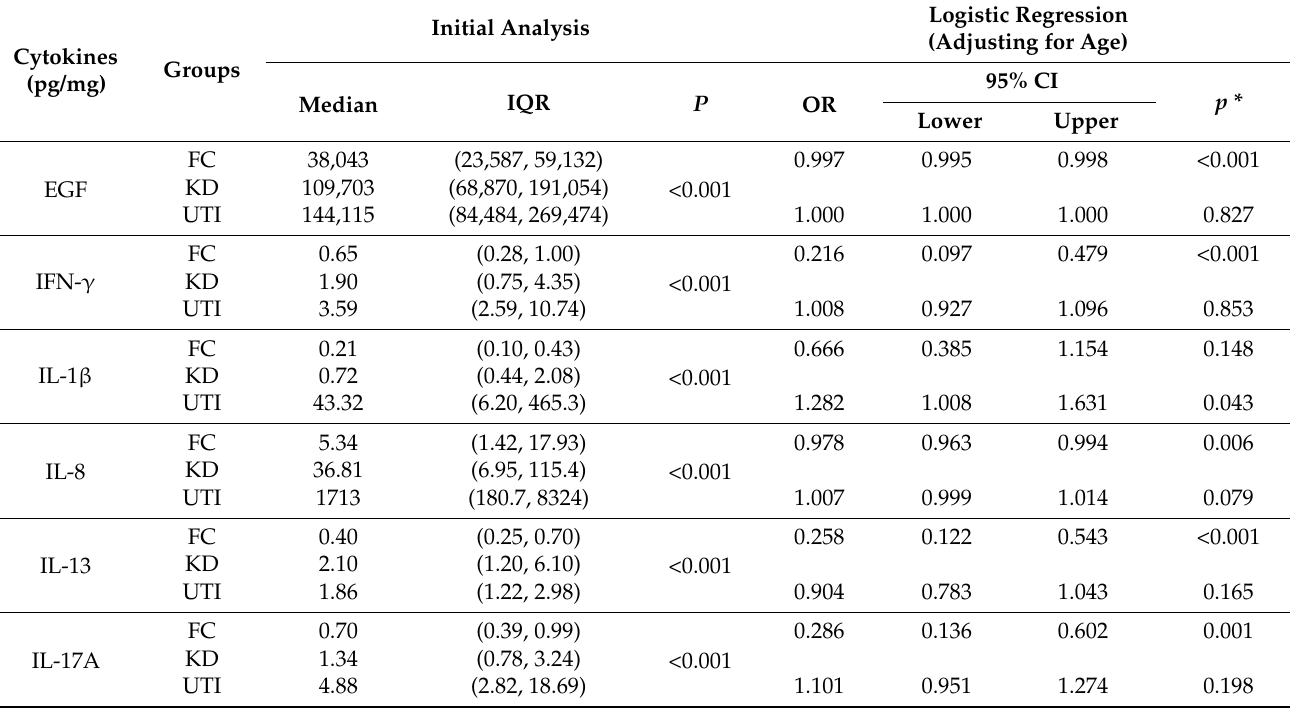
Table 3. The levels of urinary cytokines in fever-control, Kawasaki disease, and UTI groups before and after logistic regression